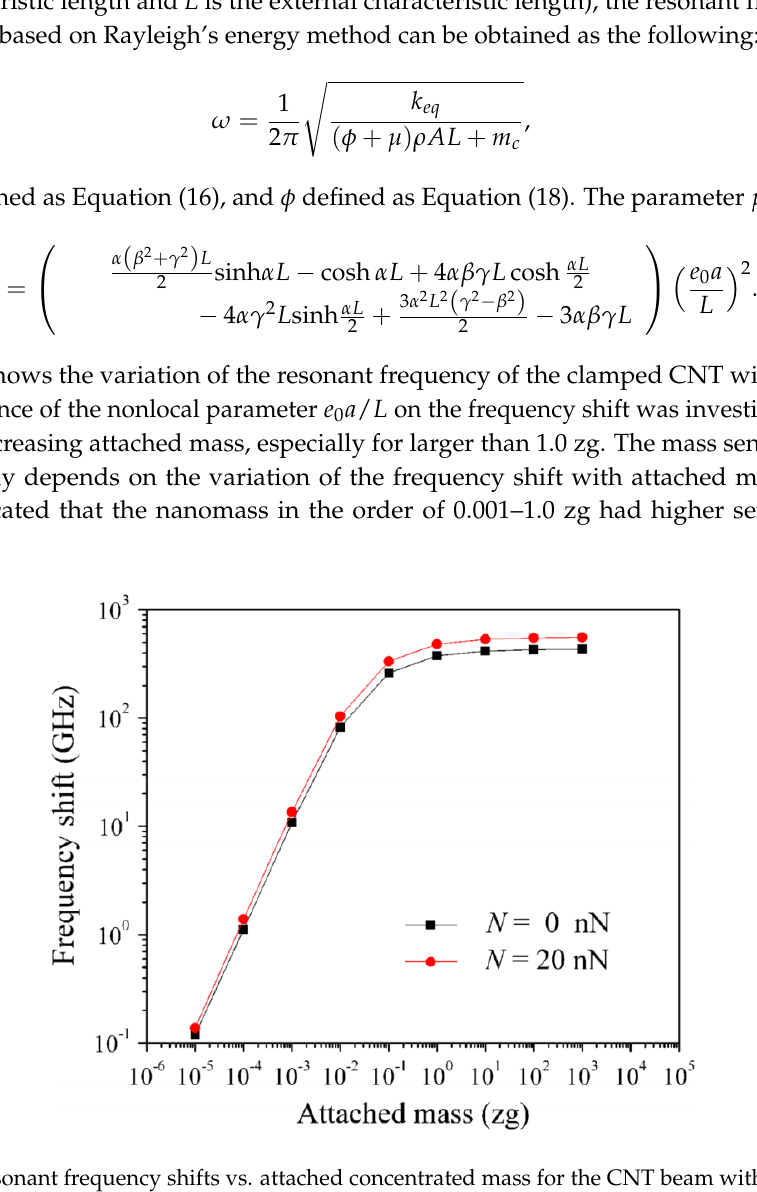
Figure 9. Resonant frequency shifts vs. attached concentrated mass for the CNT beam with axial force and without axial force. Adapted with permission from [42], Copyright Springer, 2014.